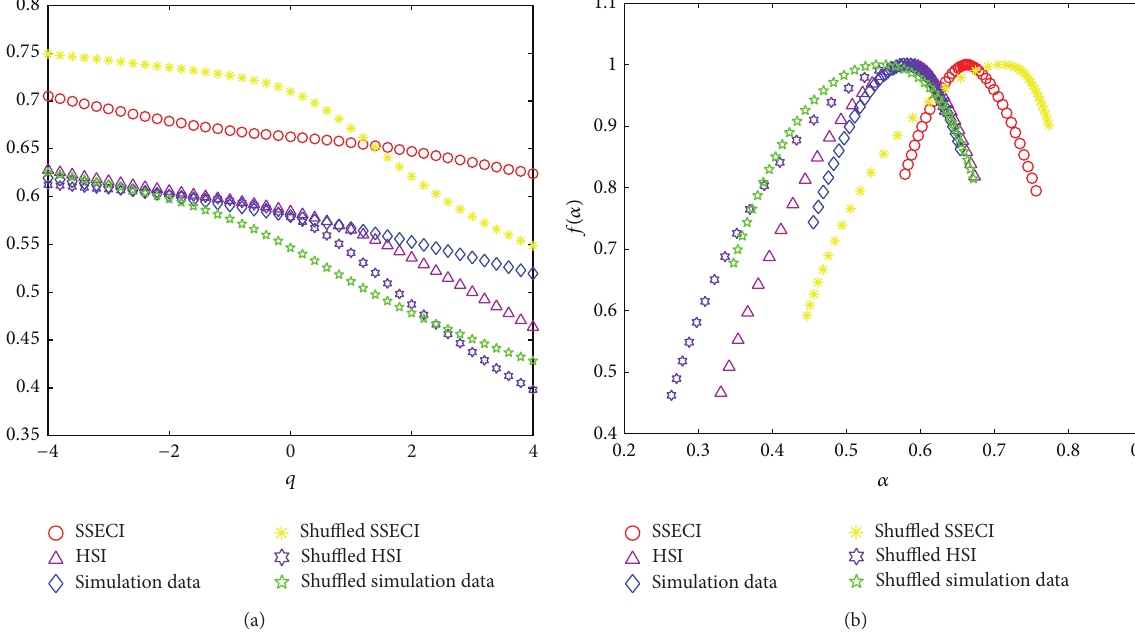
Figure 7: (a) The plot of Hurst exponent 𝐻(𝑞) versus 𝑞 for SSECI, HSI, the simulation data, and their shuffled series; (b) the plot of the corresponding singularity spectrum 𝑓(𝛼) versus 𝛼